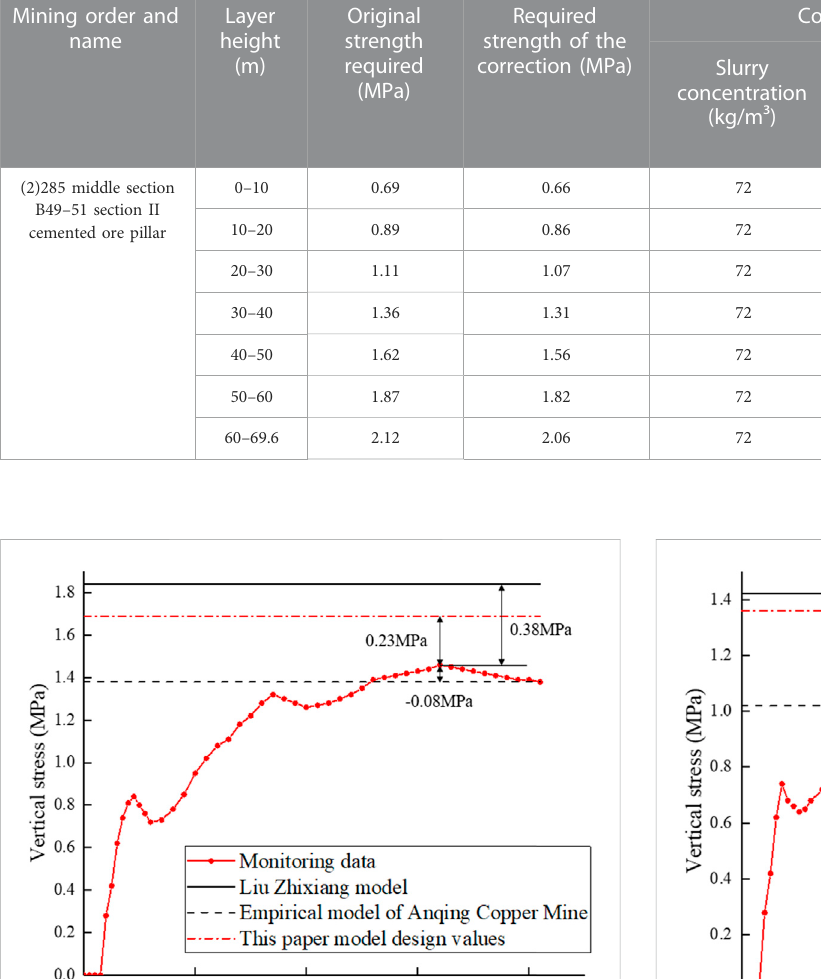
TABLE 3 Strength design of B49 – 54 line cements in the middle part of 285. Mining order and name